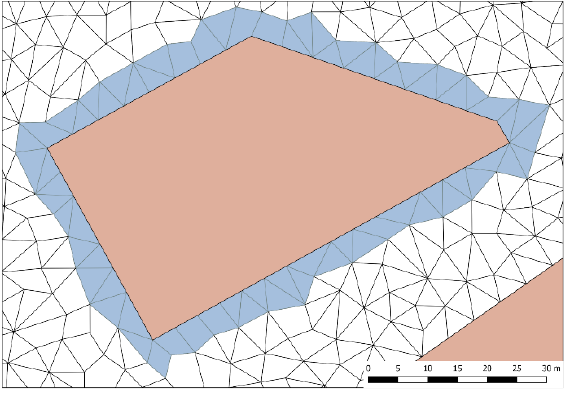
Figure 8. Unstructured mesh approach for objects in the terrain (e.g., buildings, infrastructures, etc.).